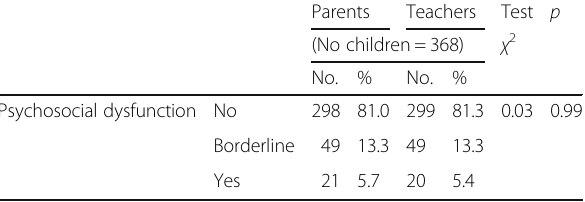
Table 3 Parents and teachers assessment of CPD among the studied children according to Strengths and Difficulties Questionnaire